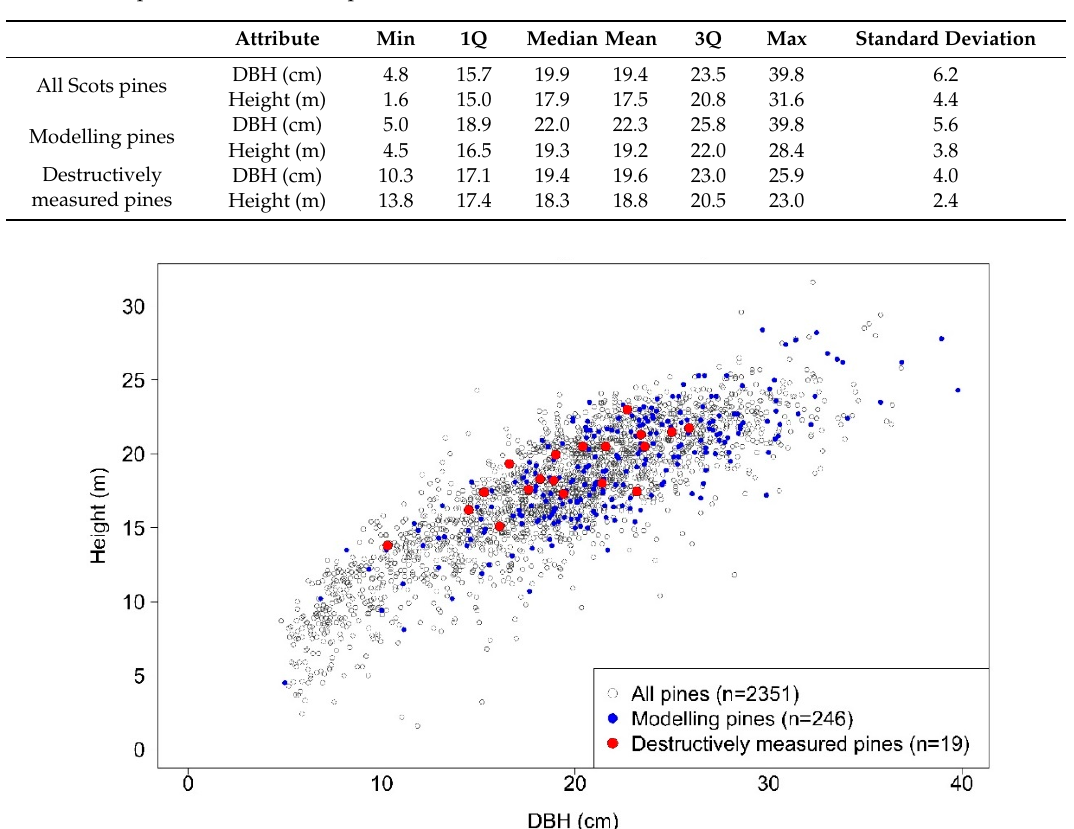
Table 1. Descriptive statistics of diameter-at-breast height (DBH) and height for all Scots pines within the 37 sample plots ( n = 2351), the modelling ( n = 246), and destructively ( n = 19) pines. Min = minimum, 1Q = 25% percentile, 3Q = 75% percentile, max = maximum.